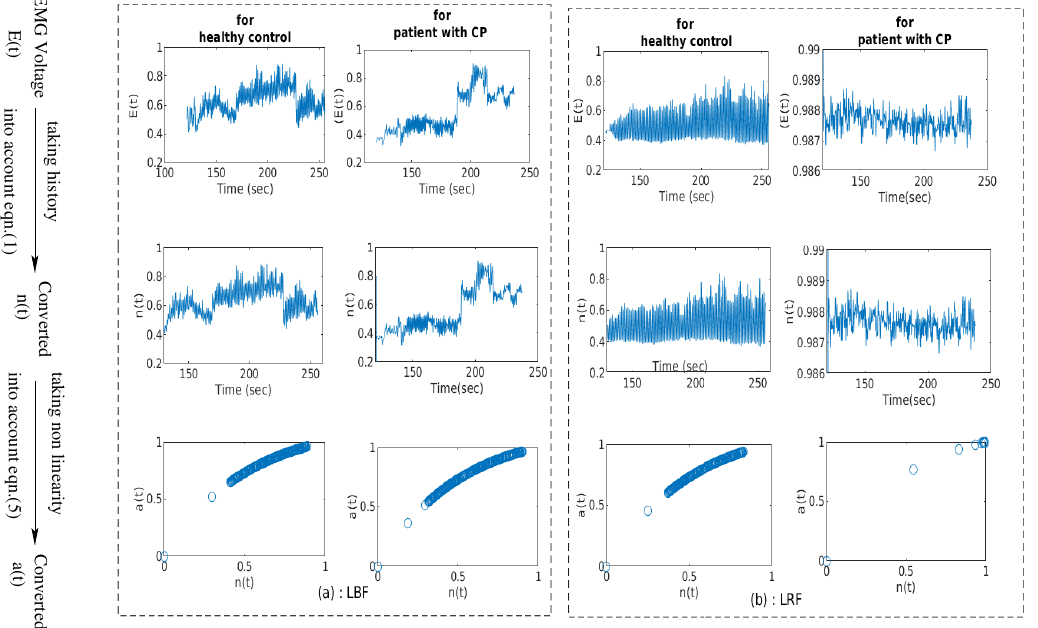
Figure 3. EMG signal E ( t ) (1st row) collected from lower extremity muscles during cycling on an ergometer and mathematical transformations (middle and bottom row) applied to E ( t ) as schematically described on the left border of the figure. The first and third panels (from left) illustrate an example from a healthy participant, and the second and fourth panels from a participant with left hemiparesis and spasticity MAS level 3. Block ( a ) refers to left biceps femoris (LBF); block ( b ) refers to left rectus femoris